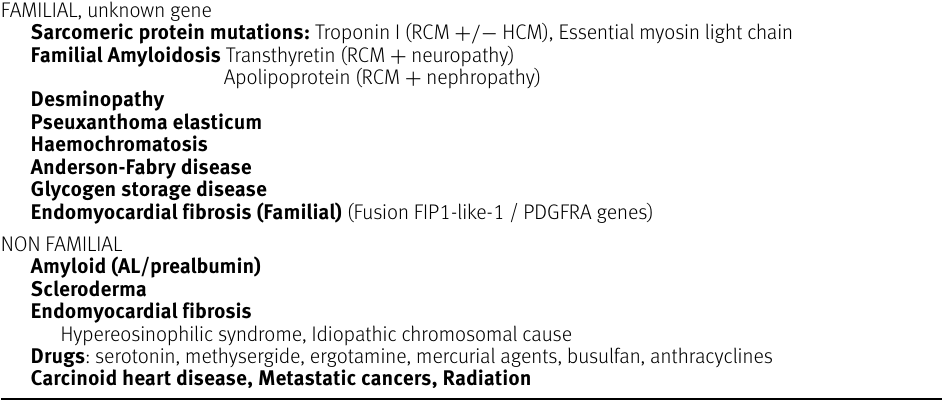
Table 3. Restrictive cardiomyopathy.